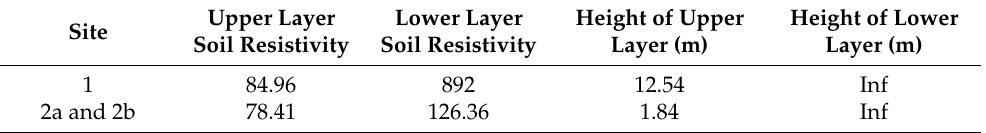
Table 1. Soil resistivity profiles of testing